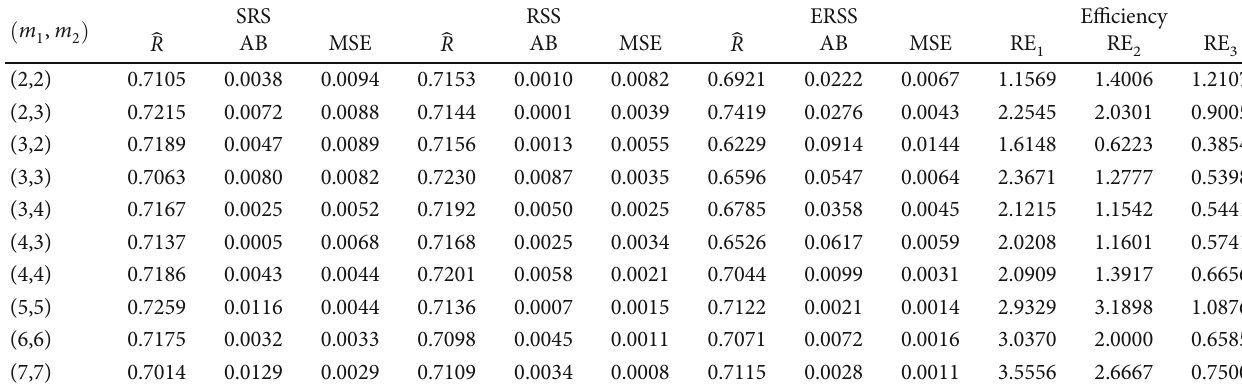
Table 5: Measures of ̂ R for di ff erent sampling schemes at R =0.714.